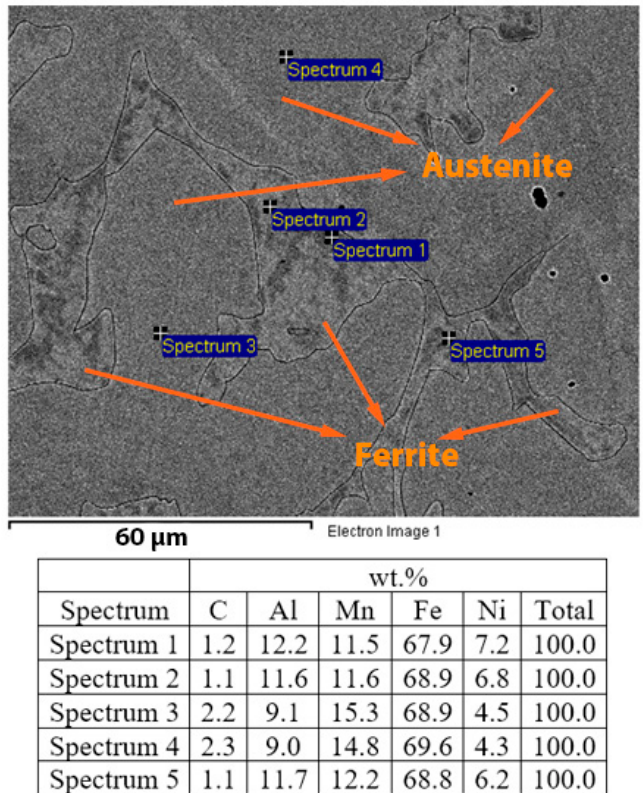
Figure 4. The areas analysed with EDS are indicated with the corresponding chemical composition in wt.%.